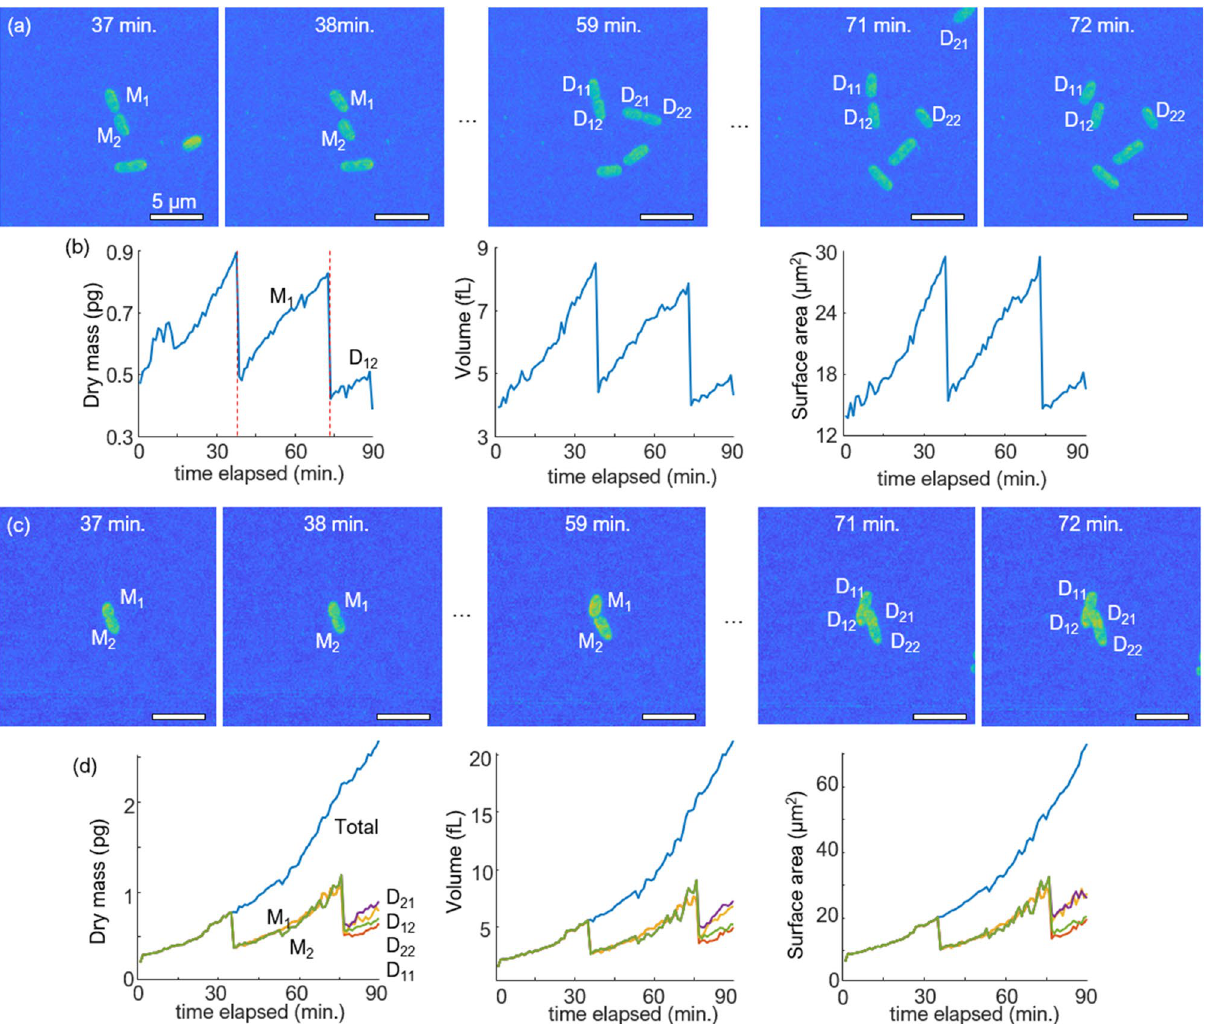
Figure 5. MIP visualization and quantitative analysis of 3D RI tomograms of K. pneumoniae in the liquid ( a , b ) and hydrogel ( c , d ) medium. The quantitative analysis includes cellular dry mass, volume, and surface area extracted from each snapshot tomogram. ( a , c ) M 1 and M 2 refer to the mother cells while D 11 , D 12 and D 21 , D 22 refer to two daughter cells from each mother cell. In ( a ), one daughter cell (D 21 ) can be seen at the upper right corner traveling out of the field of view at 71 min. ( b ) Time points showing sudden drops in cellular dry mass of K. pneumoniae are marked with red dashed lines. In ( d ), pooled data of all daughter cells and single-cell analyses are